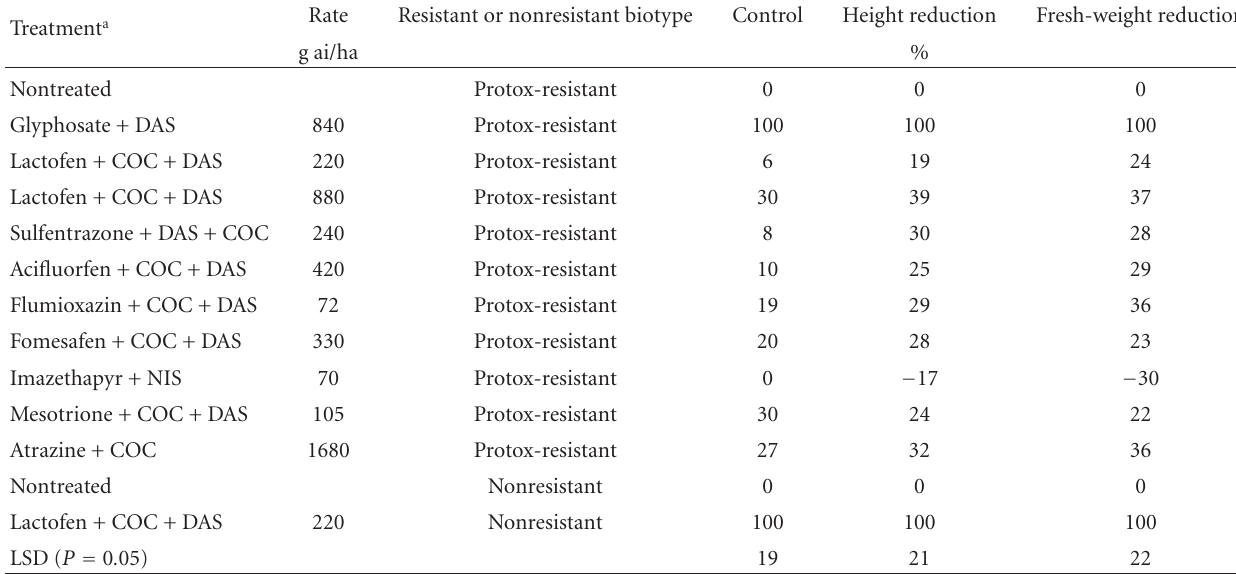
Table 4: Visual response, height reduction, and fresh-weight reduction of common waterhemp 21d after applicationin the greenhouse. Treatment a